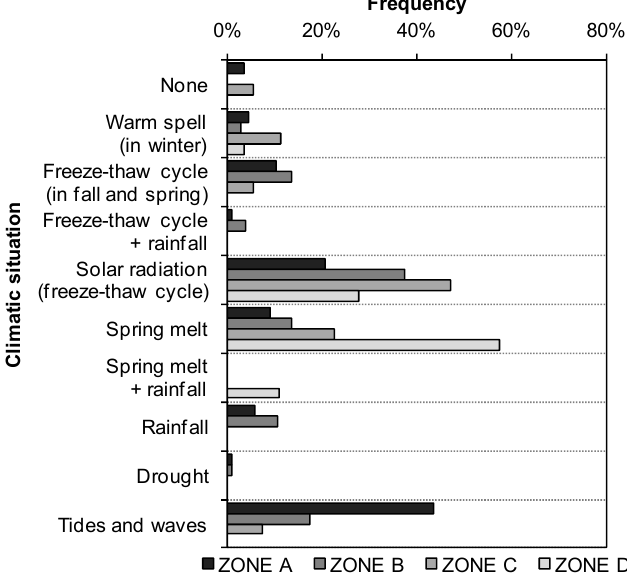
Figure 12. Climatic conditions propitious to erosion in the four monitoring zones.